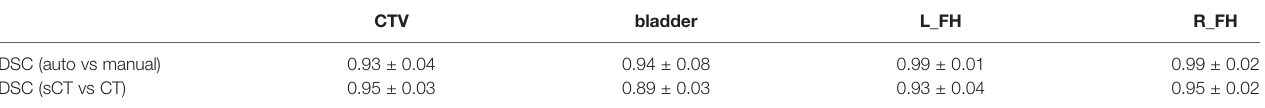
TABLE 2 | Comparison of the similarity between